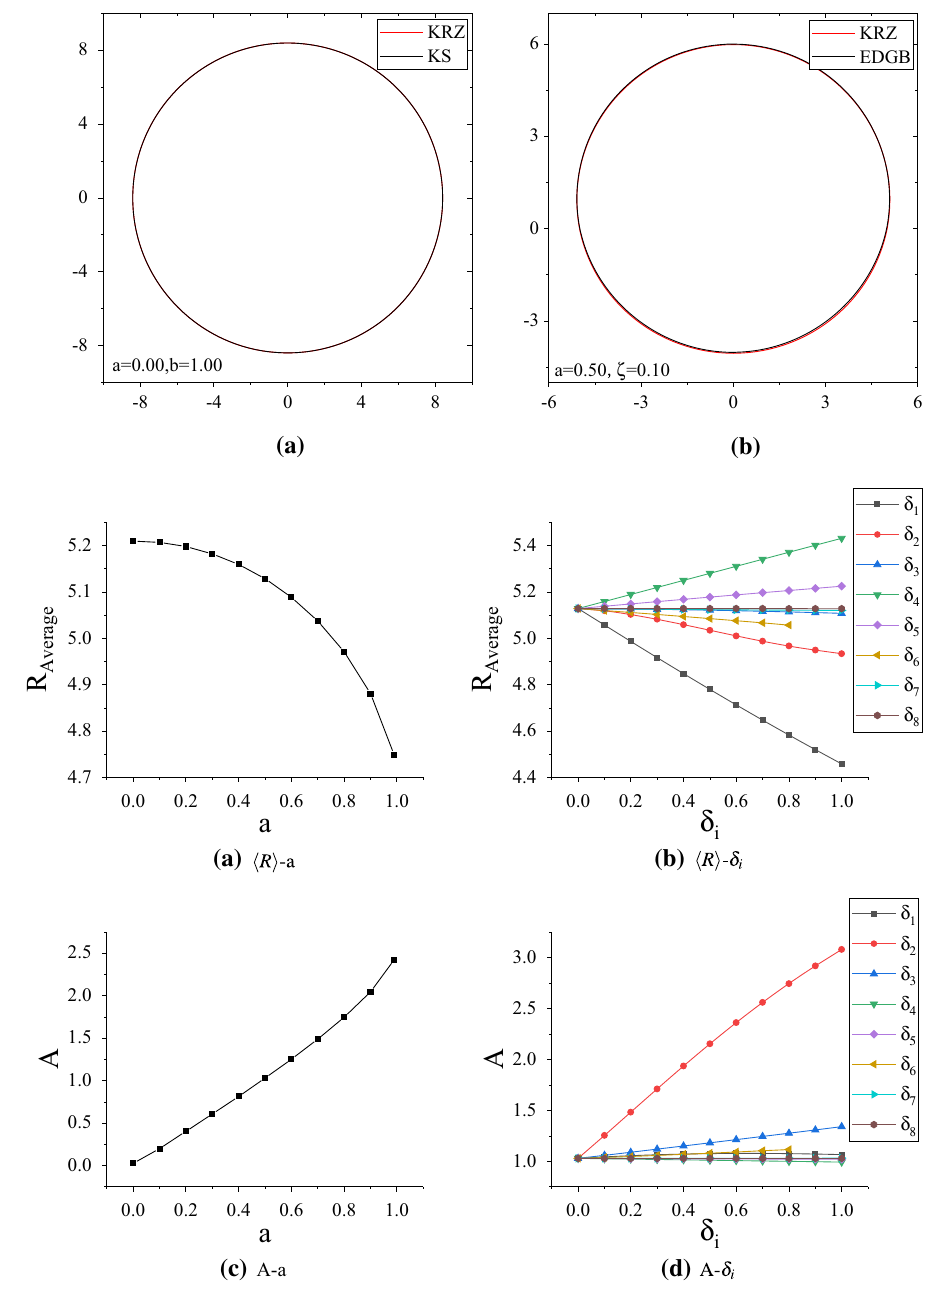
Fig. 9 The shadows of the black hole for varied metrics. Left panel: shadows of the KS and KRZ metrics. Right panel: shadows of the EDGB and KRZ metrics. a is the value of spin, b is the value of scalar(dilaton) field and ζ is the value of deformation